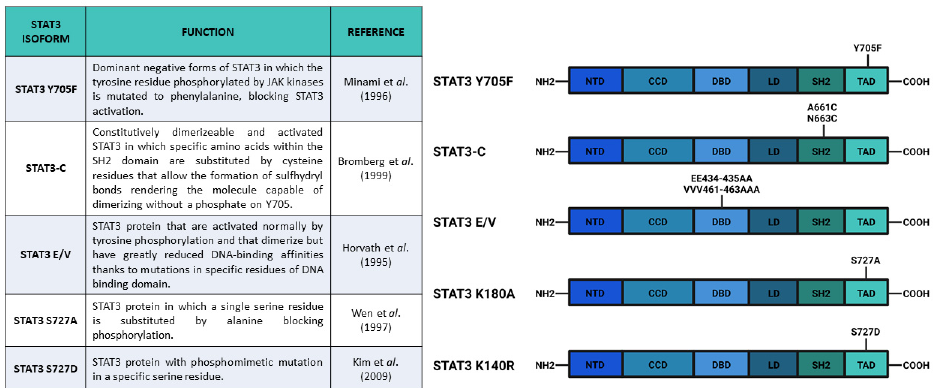
Figure 3. Main constructs used to investigate STAT3 phosphorylation. Created with